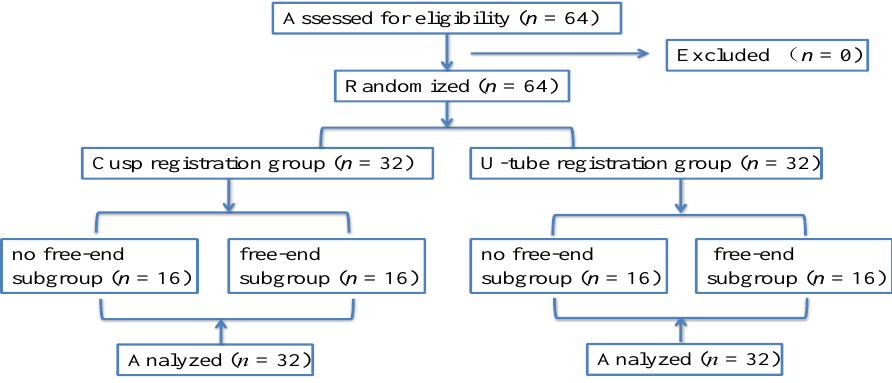
Figure 1. Consort flow diagram showing the grouping of this